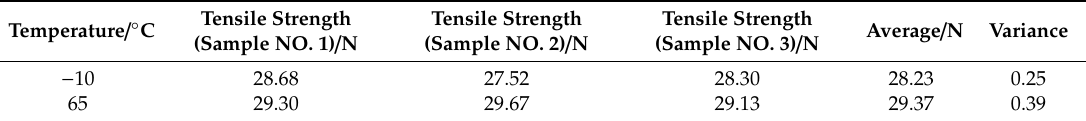
Table 6. Tensile properties of the blade root at the highest and lowest temperatures.